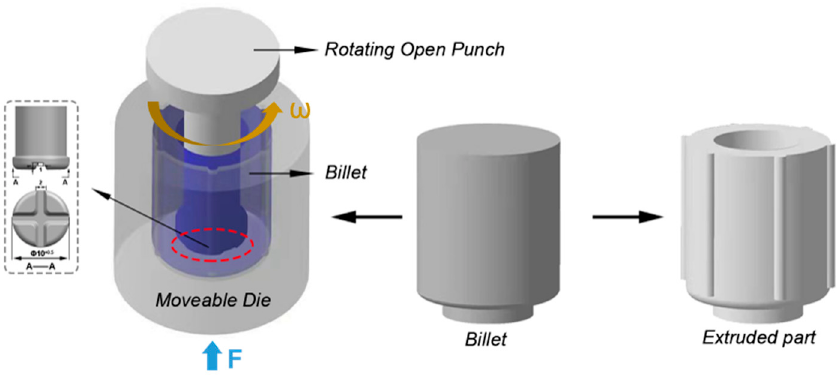
Figure 1. Schematic illustrations of rotating backward extrusion (RBE) process.